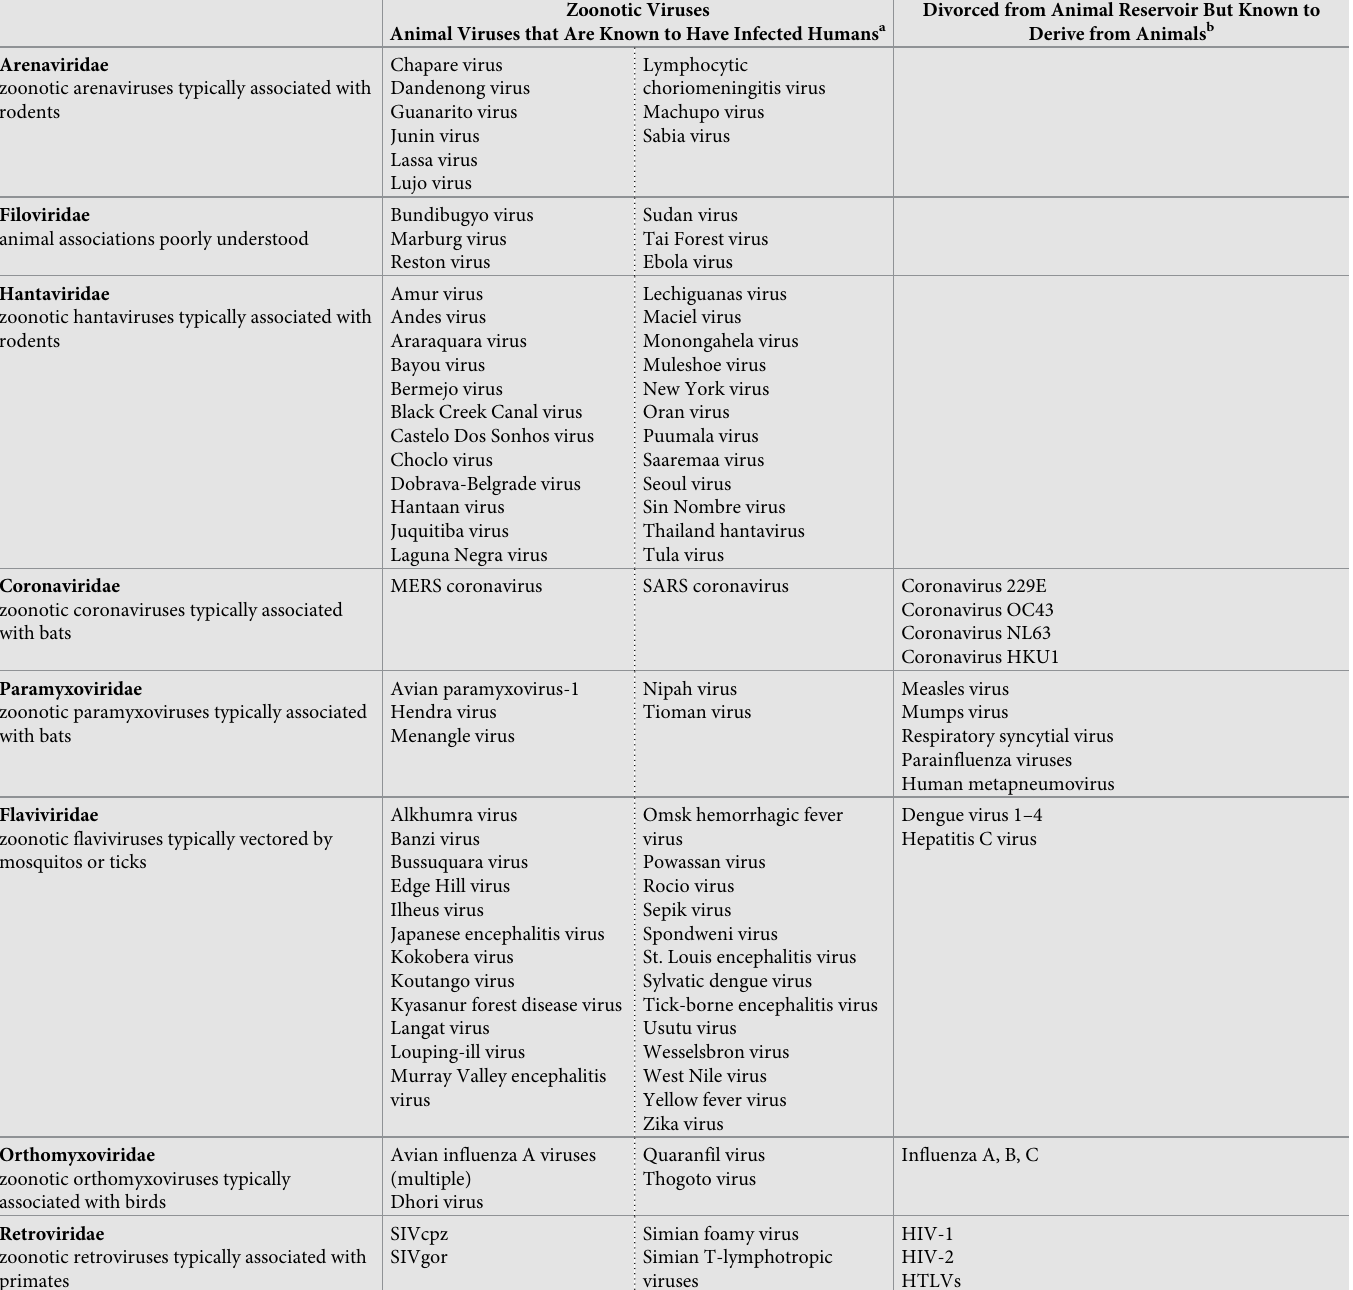
Divorced from Animal Reservoir But Known to Derive from Animals b